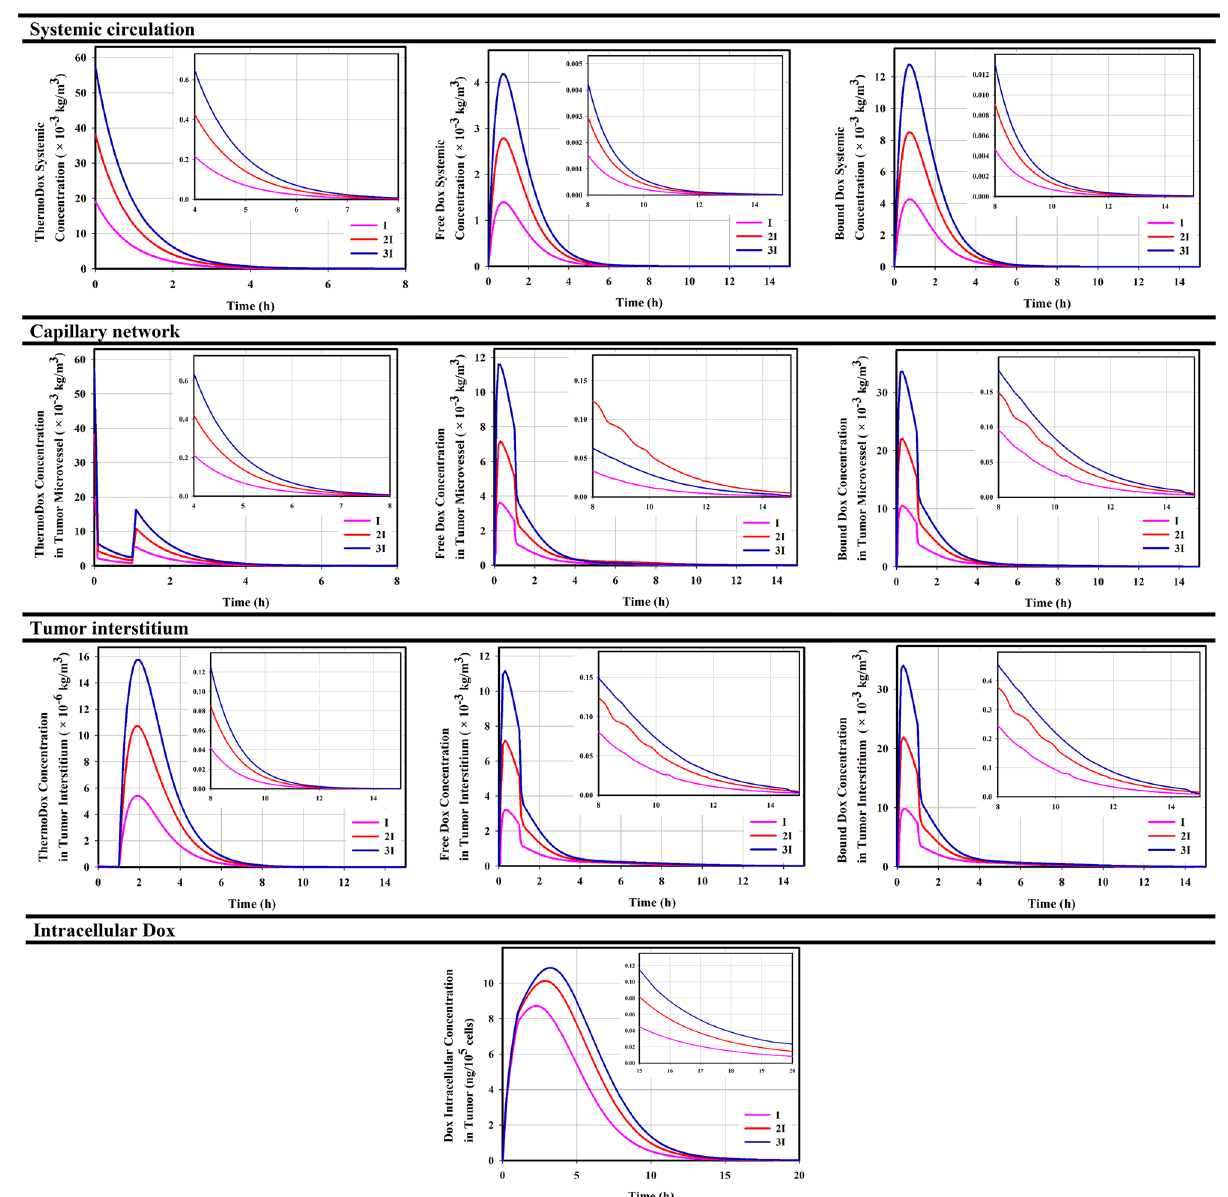
Figure 4. Temporal distribution of drug at different compartments during ThermoDox-mediated delivery; Increasing the injected dose of ThermoDox enhances the concentration of therapeutic agents at each stage = 0.0191 kg , 2 I = 0.0382 kg , 3 I = 0.0573 kg . The concentration of free and bound drugs in the capillary (cid:31) I m 3 m 3 m 3 (cid:30) network is more than twice that of systemic plasma, which rapidly crosses the vessel wall and enters the tumor interstitium. The bound drug has similar variation with the free drug, but nearly three times greater. Concentration in intracellular compartment could have more drug due to the high extracellular concentration of